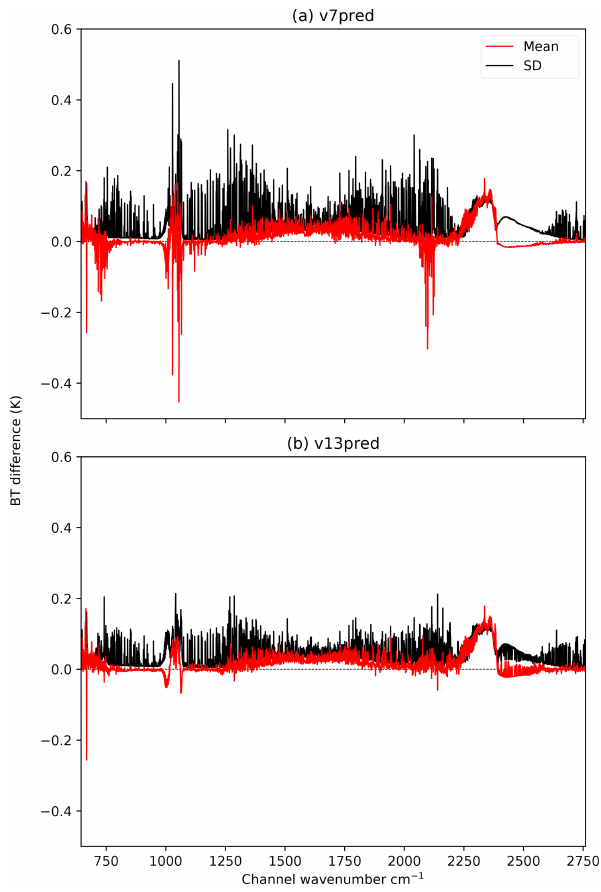
Figure 8. RTTOV vs. brightness temperatures calculated from channel-integrated LBLRTM radiances for IASI (a) v9 predictors (all gases except SO 2 ) and (b) v13 predictors (all seven variable gases) for 52 independent profiles with varying water vapour, O 3 , and CO 2